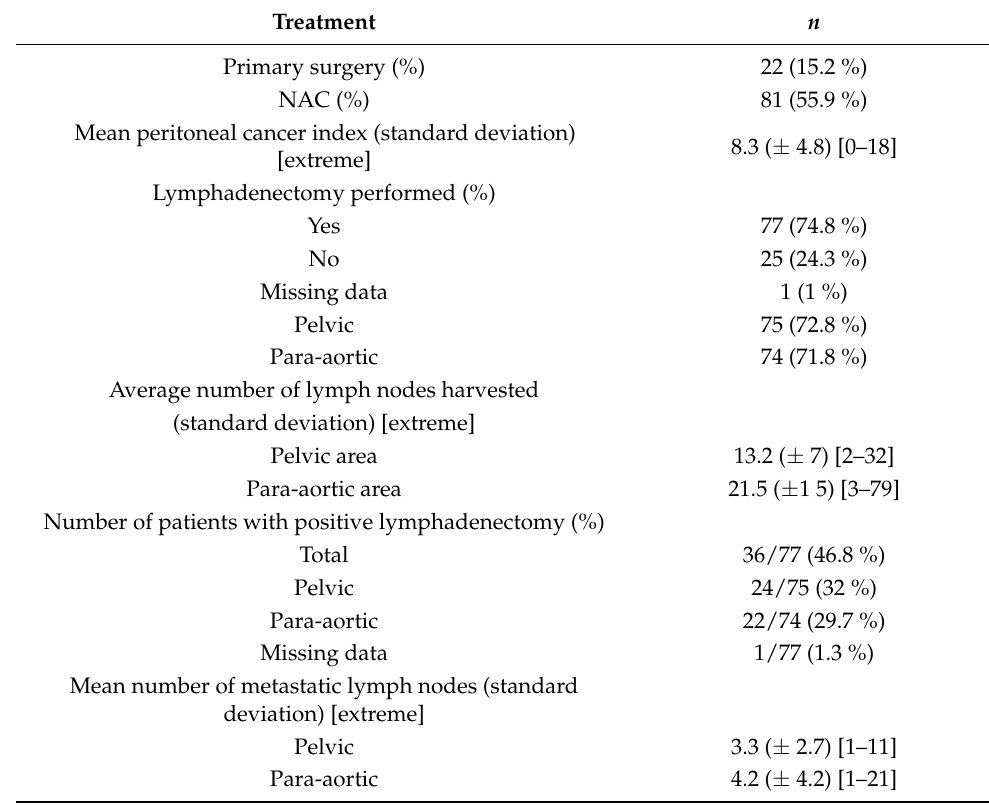
Table 2. Key data for cytoreduction surgery ( n = 103).